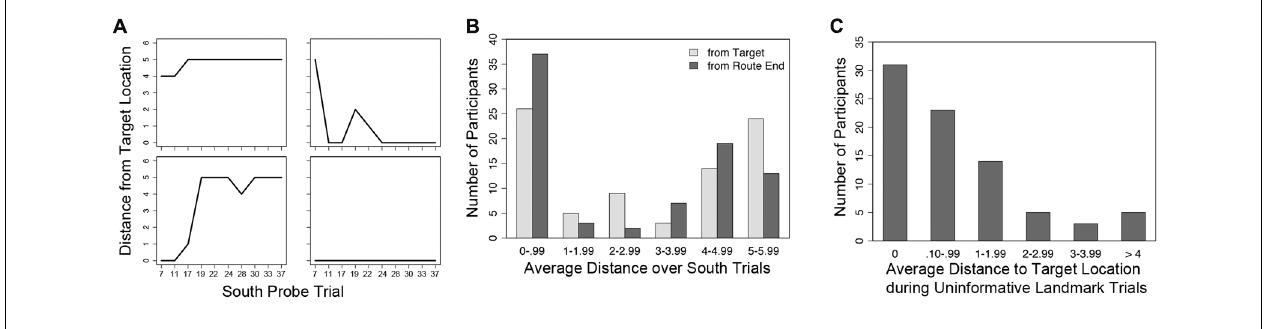
males; (B) frequencies for average distance from the target location and route end among all subjects during South probe trials; (C) frequencies for average distance from the target location among all subjects during Uninformative Landmark